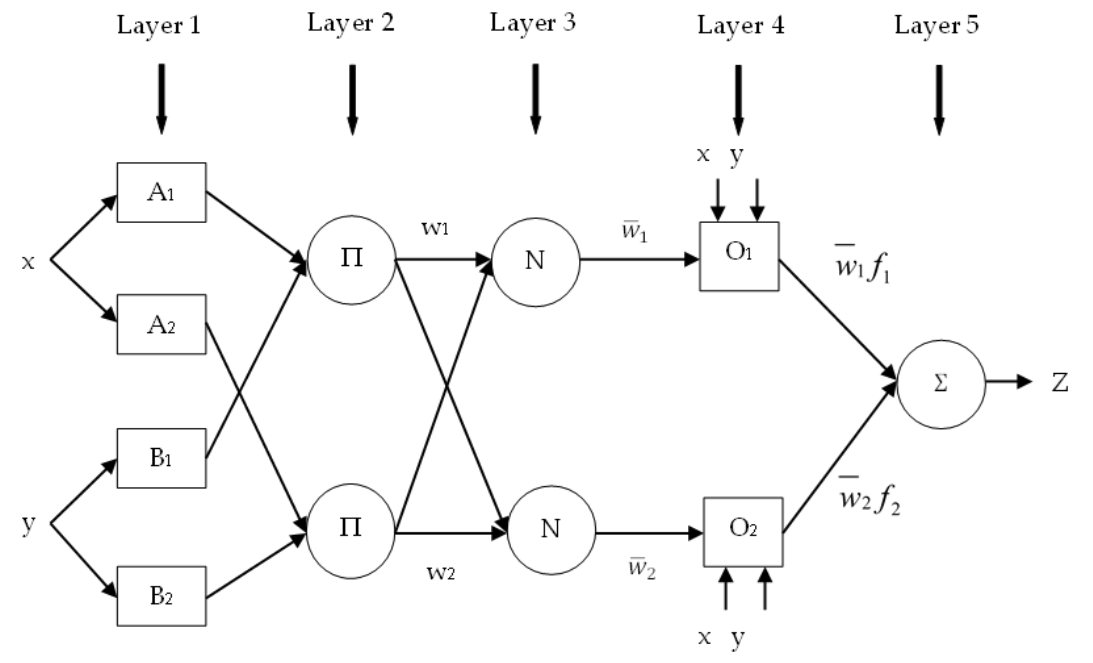
Figure 4. Schematic demonstration of ANFIS structure.